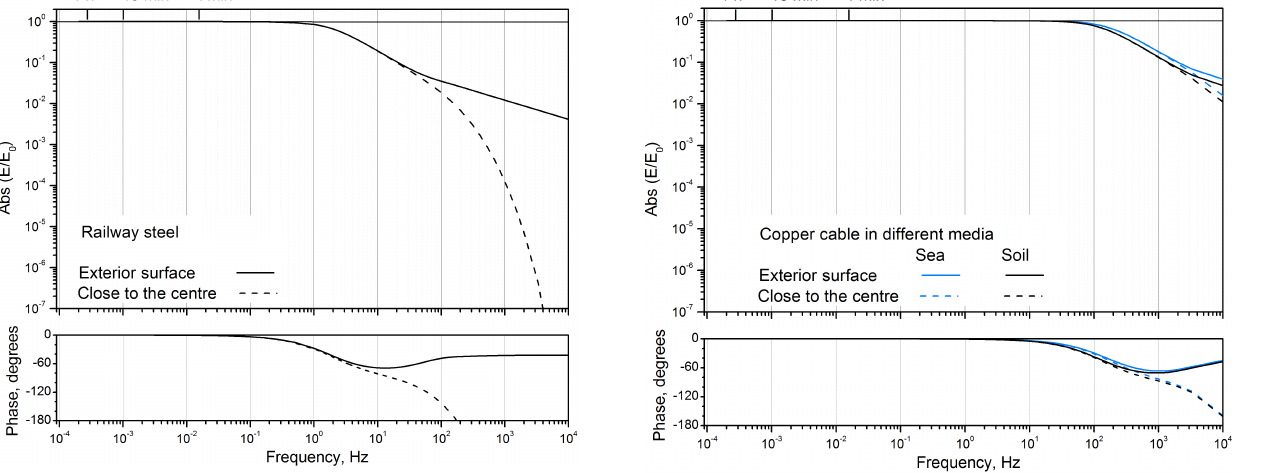
Figure 4. The frequency dependencies of normalized absolute am- plitude (top) and phase (bottom) of the electric field at the outer surface and near the centre of the copper layer in cable, for two cases of external media, soil with conductivity of 10 − 3 Sm − 1 and sea with conductivity of 1Sm − 1 .